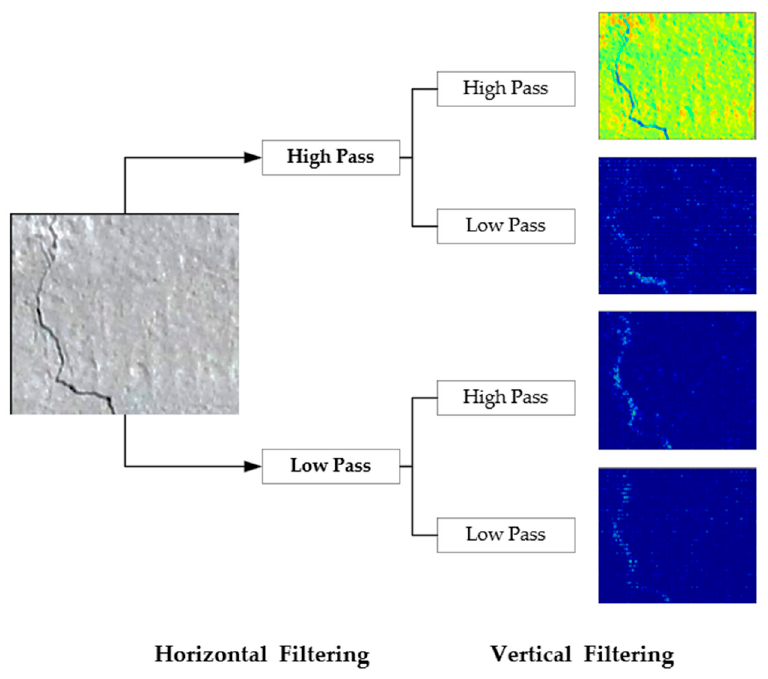
Figure 2. Image decomposition using 2D-DWT.